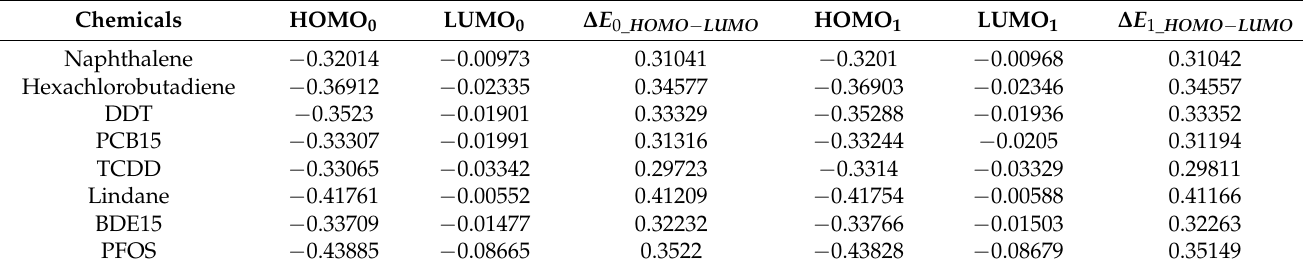
Table 5. HOMO, LUMO, and the corresponding gap of POPs